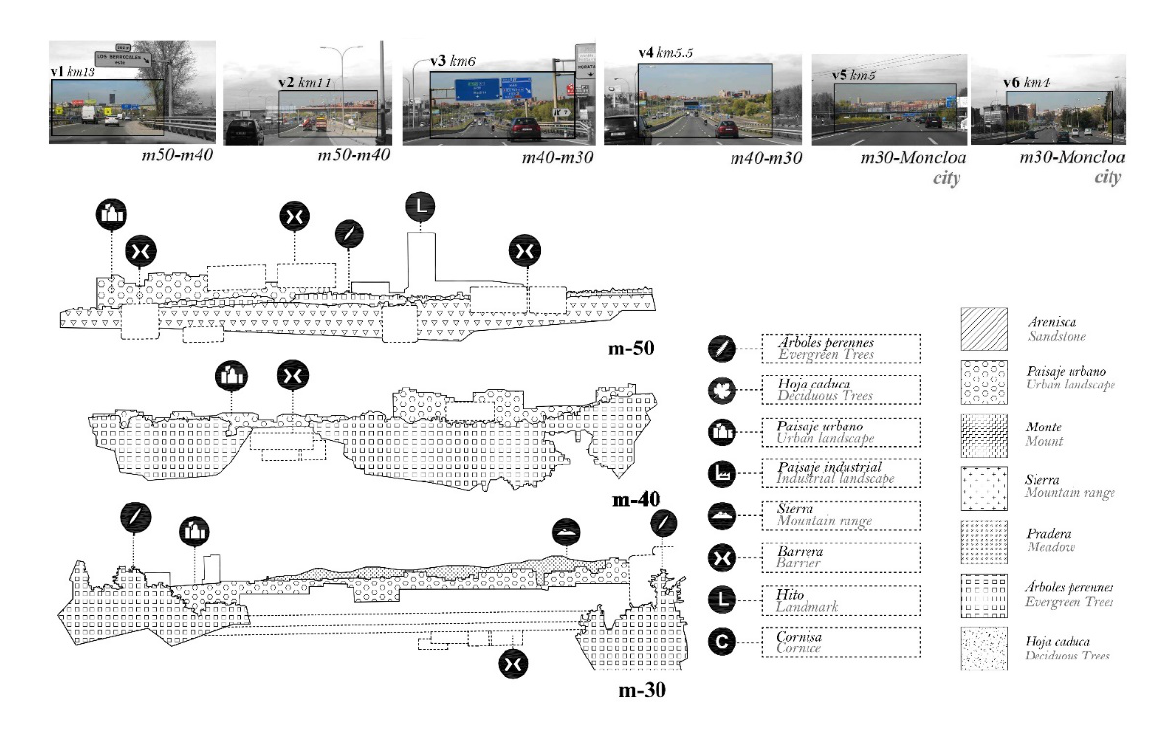
Figure 11: Selected frames and interpretive drawings from the analysis throughout the A3 road